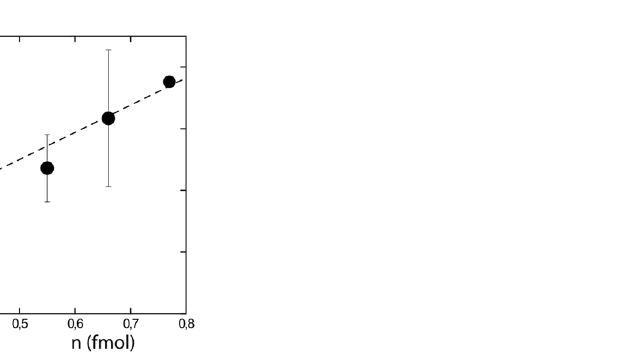
Figure 2. MALDI-TOF MS spectra of 5 femtomoles of Ang II. Left. Standard pipette deposition. Right. DMF deposition. Inserts: Dried mixture of peptide/matrix before laser desorption.